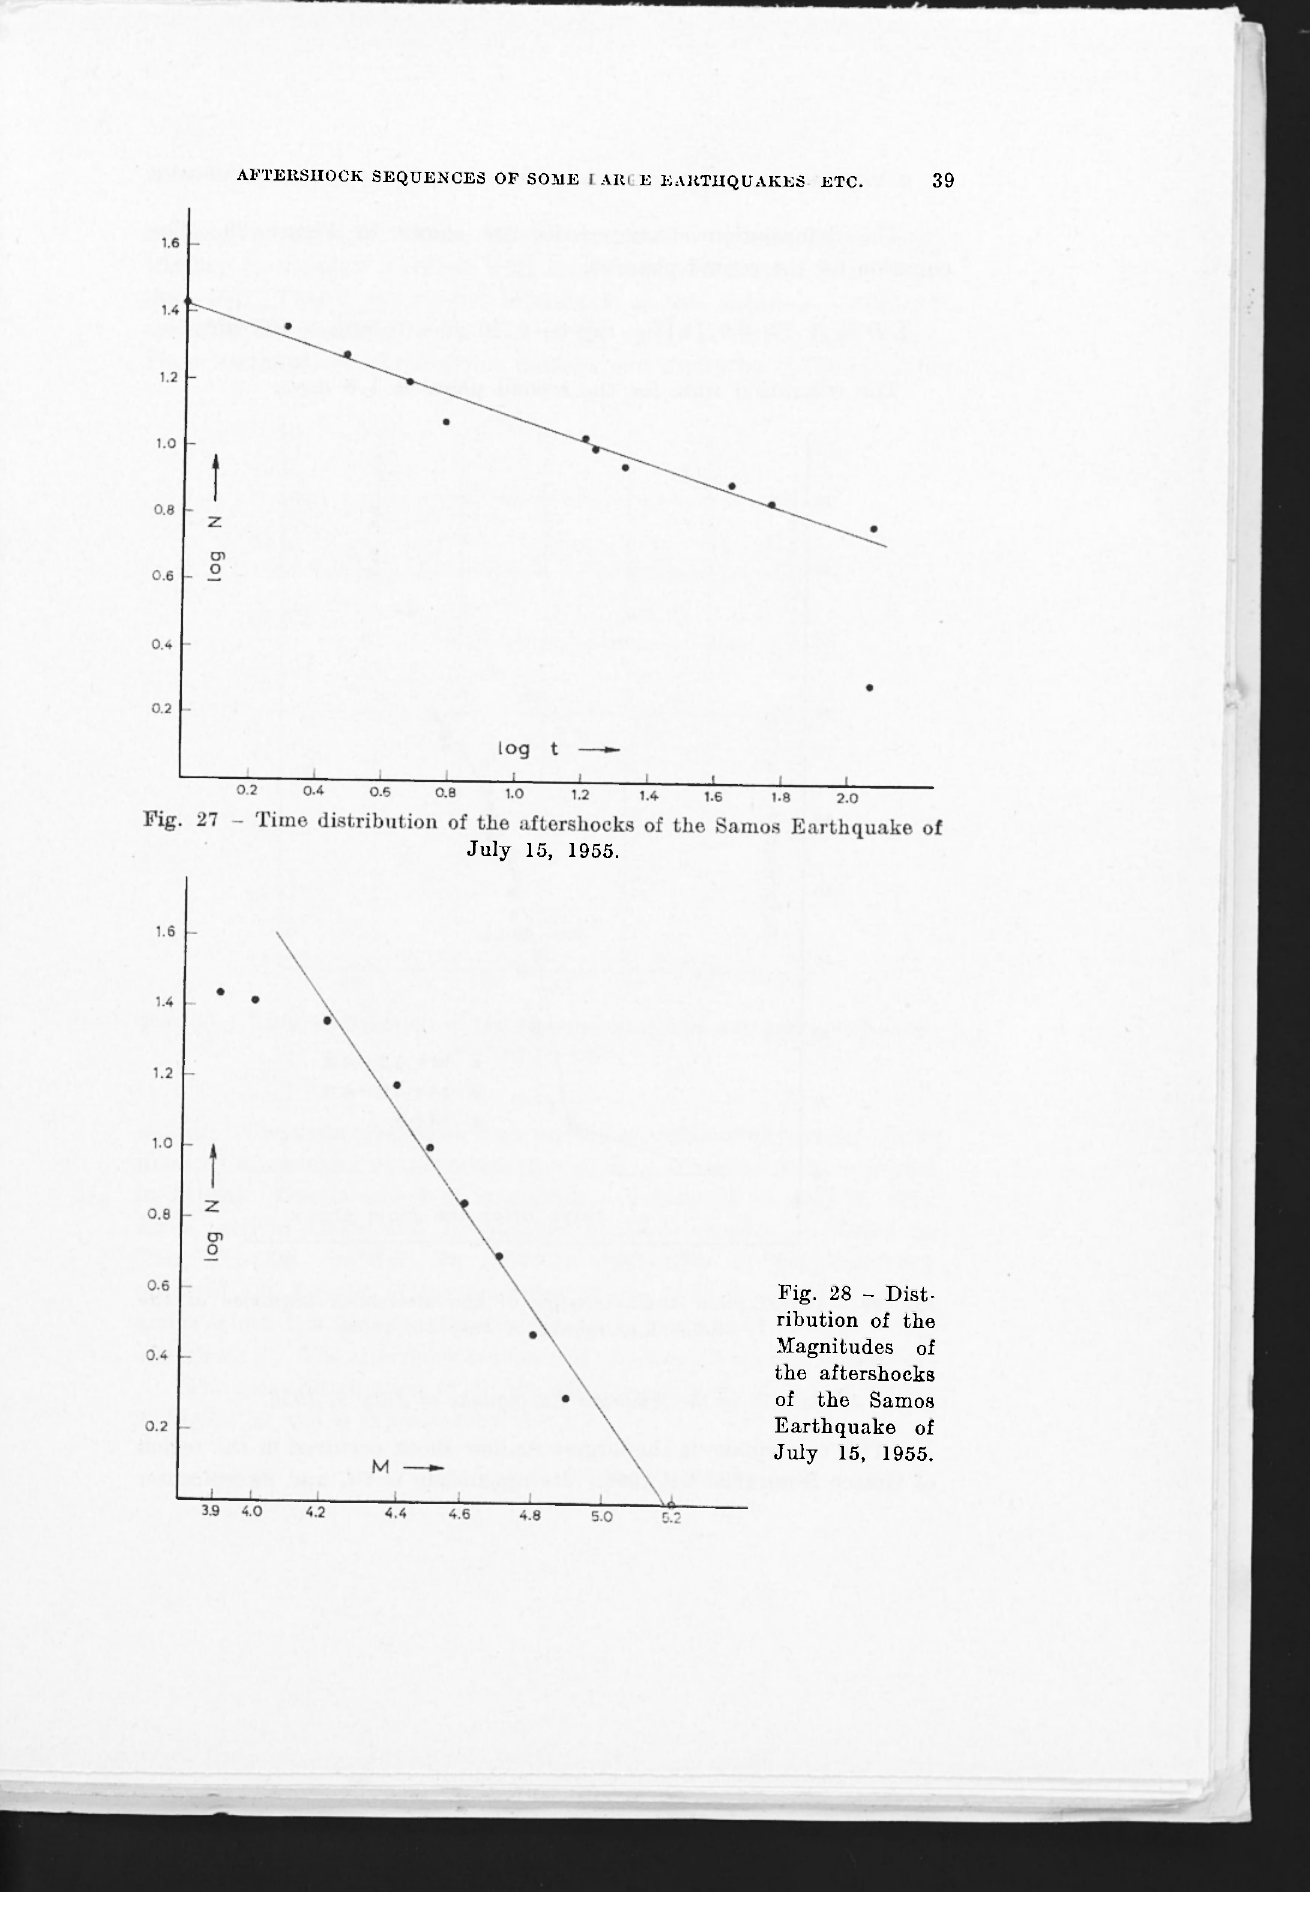
Fig. 28 - Dist- ribution of the Magnitudes of the aftershocks of the Samos Earthquake of July 15,